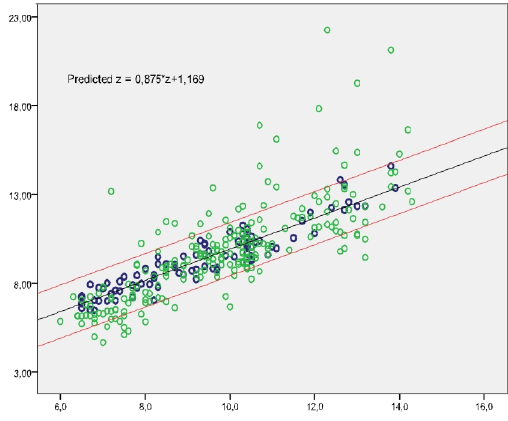
Figure 2. The graphic expression of model in area A. The red lines represent the limits of confidence interval of estimated individual values. Blue circles depict the control points and green circles depict the depth estimation points. Estimated depths are on y-axis.